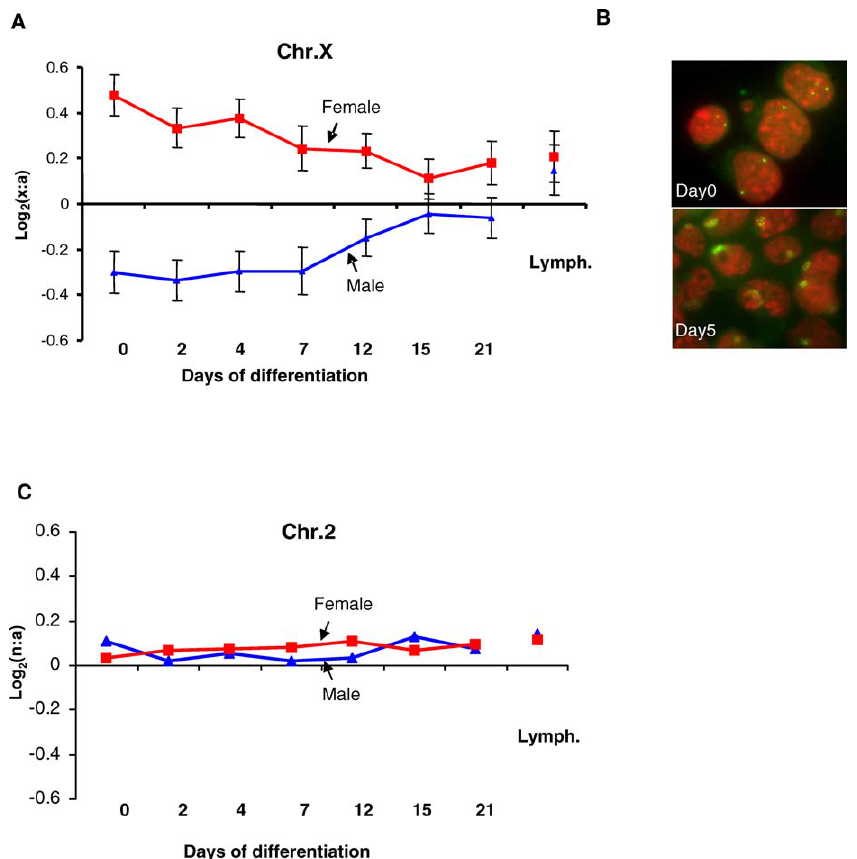
Figure 3. Dynamics of Change in X-Linked Gene and Autosomal Gene Expression during ES Cell Differentiation (A) Expression of X-linked genes (X:A ratio, log 2 scale) in female (red) and male (blue) ES cells at different stages of differentiation from day 0 (undifferentiated) to day 21. Each data point ( 6 SE) is the averaged median value from 5 (day 21), 4 (day 0), 3 (day 12), or 2 (days 2, 4, 7, 15) biological replicates. (See Text S1 for details). (B) RNA FISH showing distribution of Xist RNA (green) in undifferentiated (day 0, upper panel) and differentiating (day 5, lower panel) female ES cells, counterstained with DAPI (red). The prominent, widely spread Xist signal was detected in ; 60% of day 5 cells. (C) Expression of genes on Chromosome 2 (n:A ratio, log 2 scale) in female (red) and male (blue) ES cells at different stages of differentiation. Replicates as in (A).